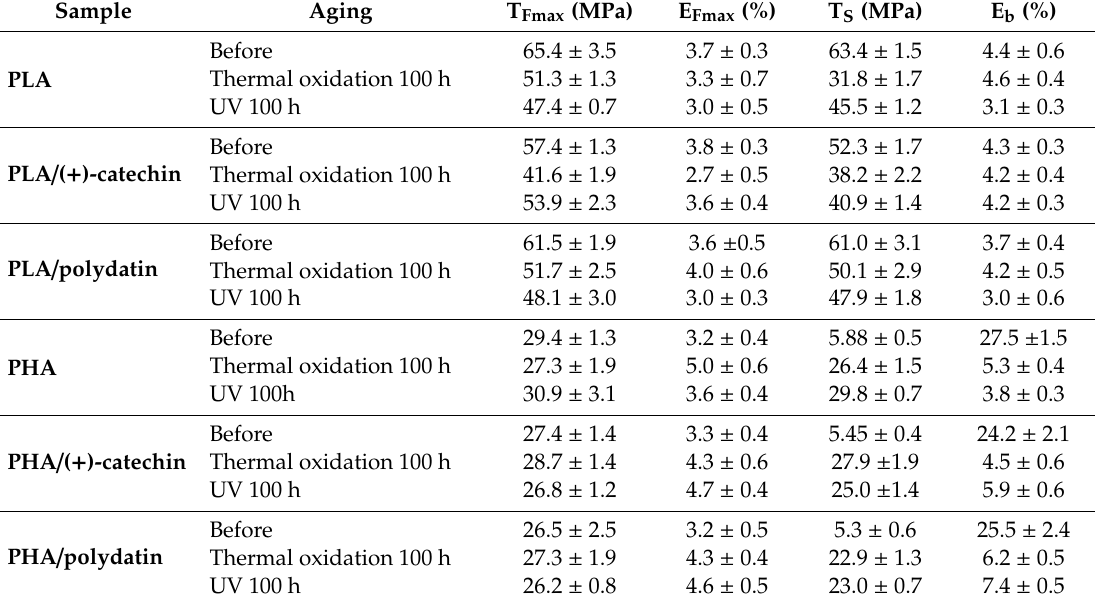
Table 1. Mechanical properties of polylactide (PLA) and polyhydroxyalkanoate (PHA) samples with natural polyphenols. T Fmax , the maximum stress transferred by the sample (MPa); E Fmax , the maximum elongation of the sample at break (%); T S , the tensile strength (MPa); and E, the elongation at break (%).